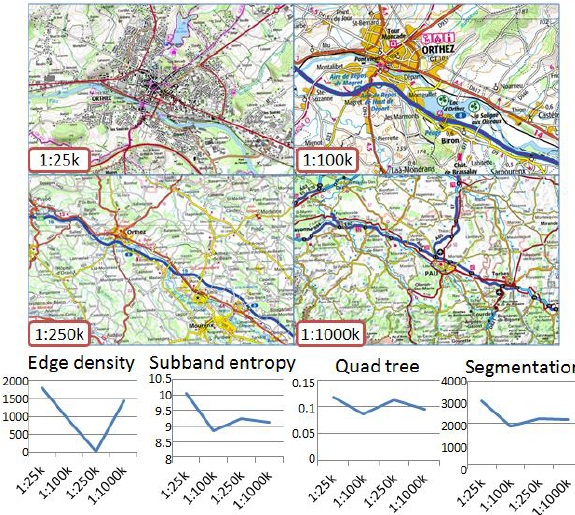
Figure 7. Evolution of clutter when scale decreases